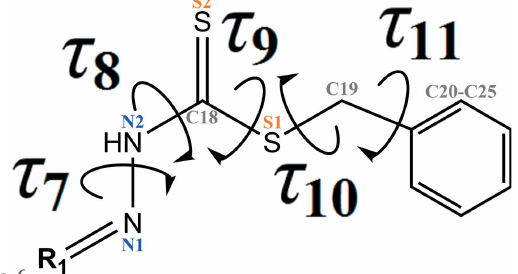
Figure 6 General chemical scheme showing the definition of torsion angles, (cid:3) 7 , (cid:3) 8 , (cid:3) 9 , (cid:3) 10 and (cid:3) 11 in the benzyl hydrazine-1-carbothioate